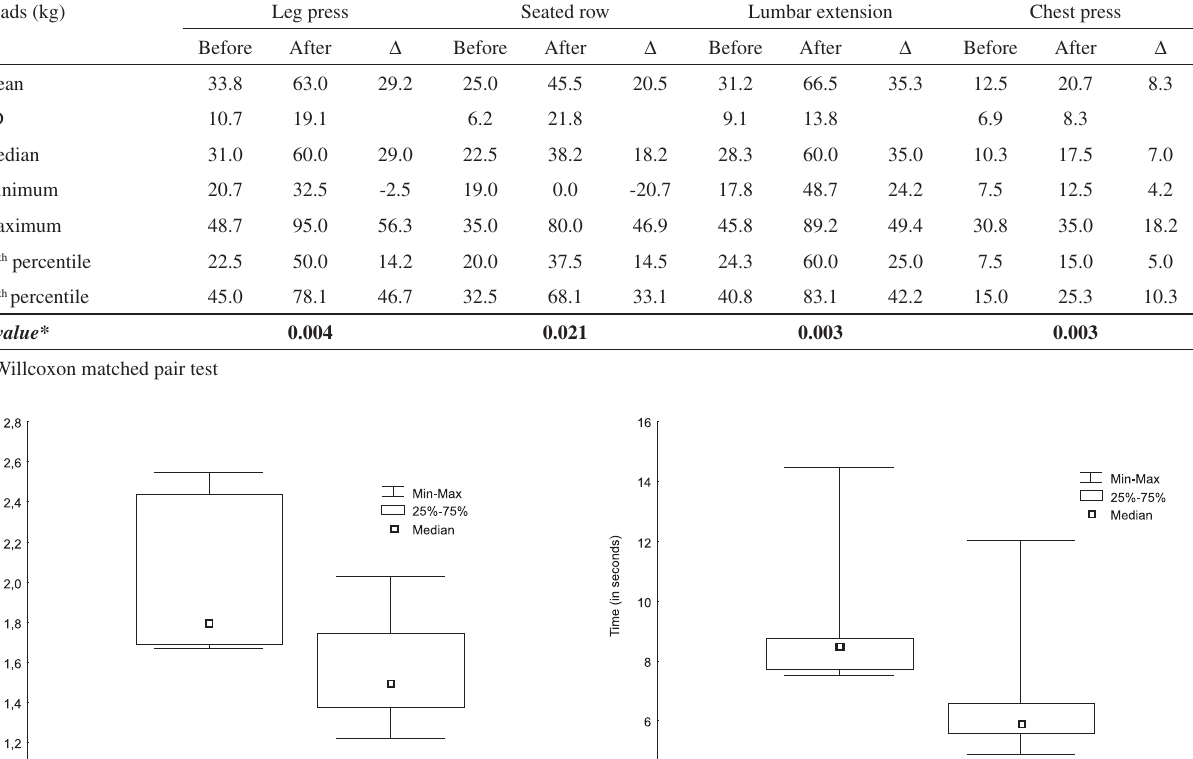
Table 2 - Load variations of four exercises after one year of resistance training Loads (kg) Leg press Seated row Lumbar extension Chest press Before